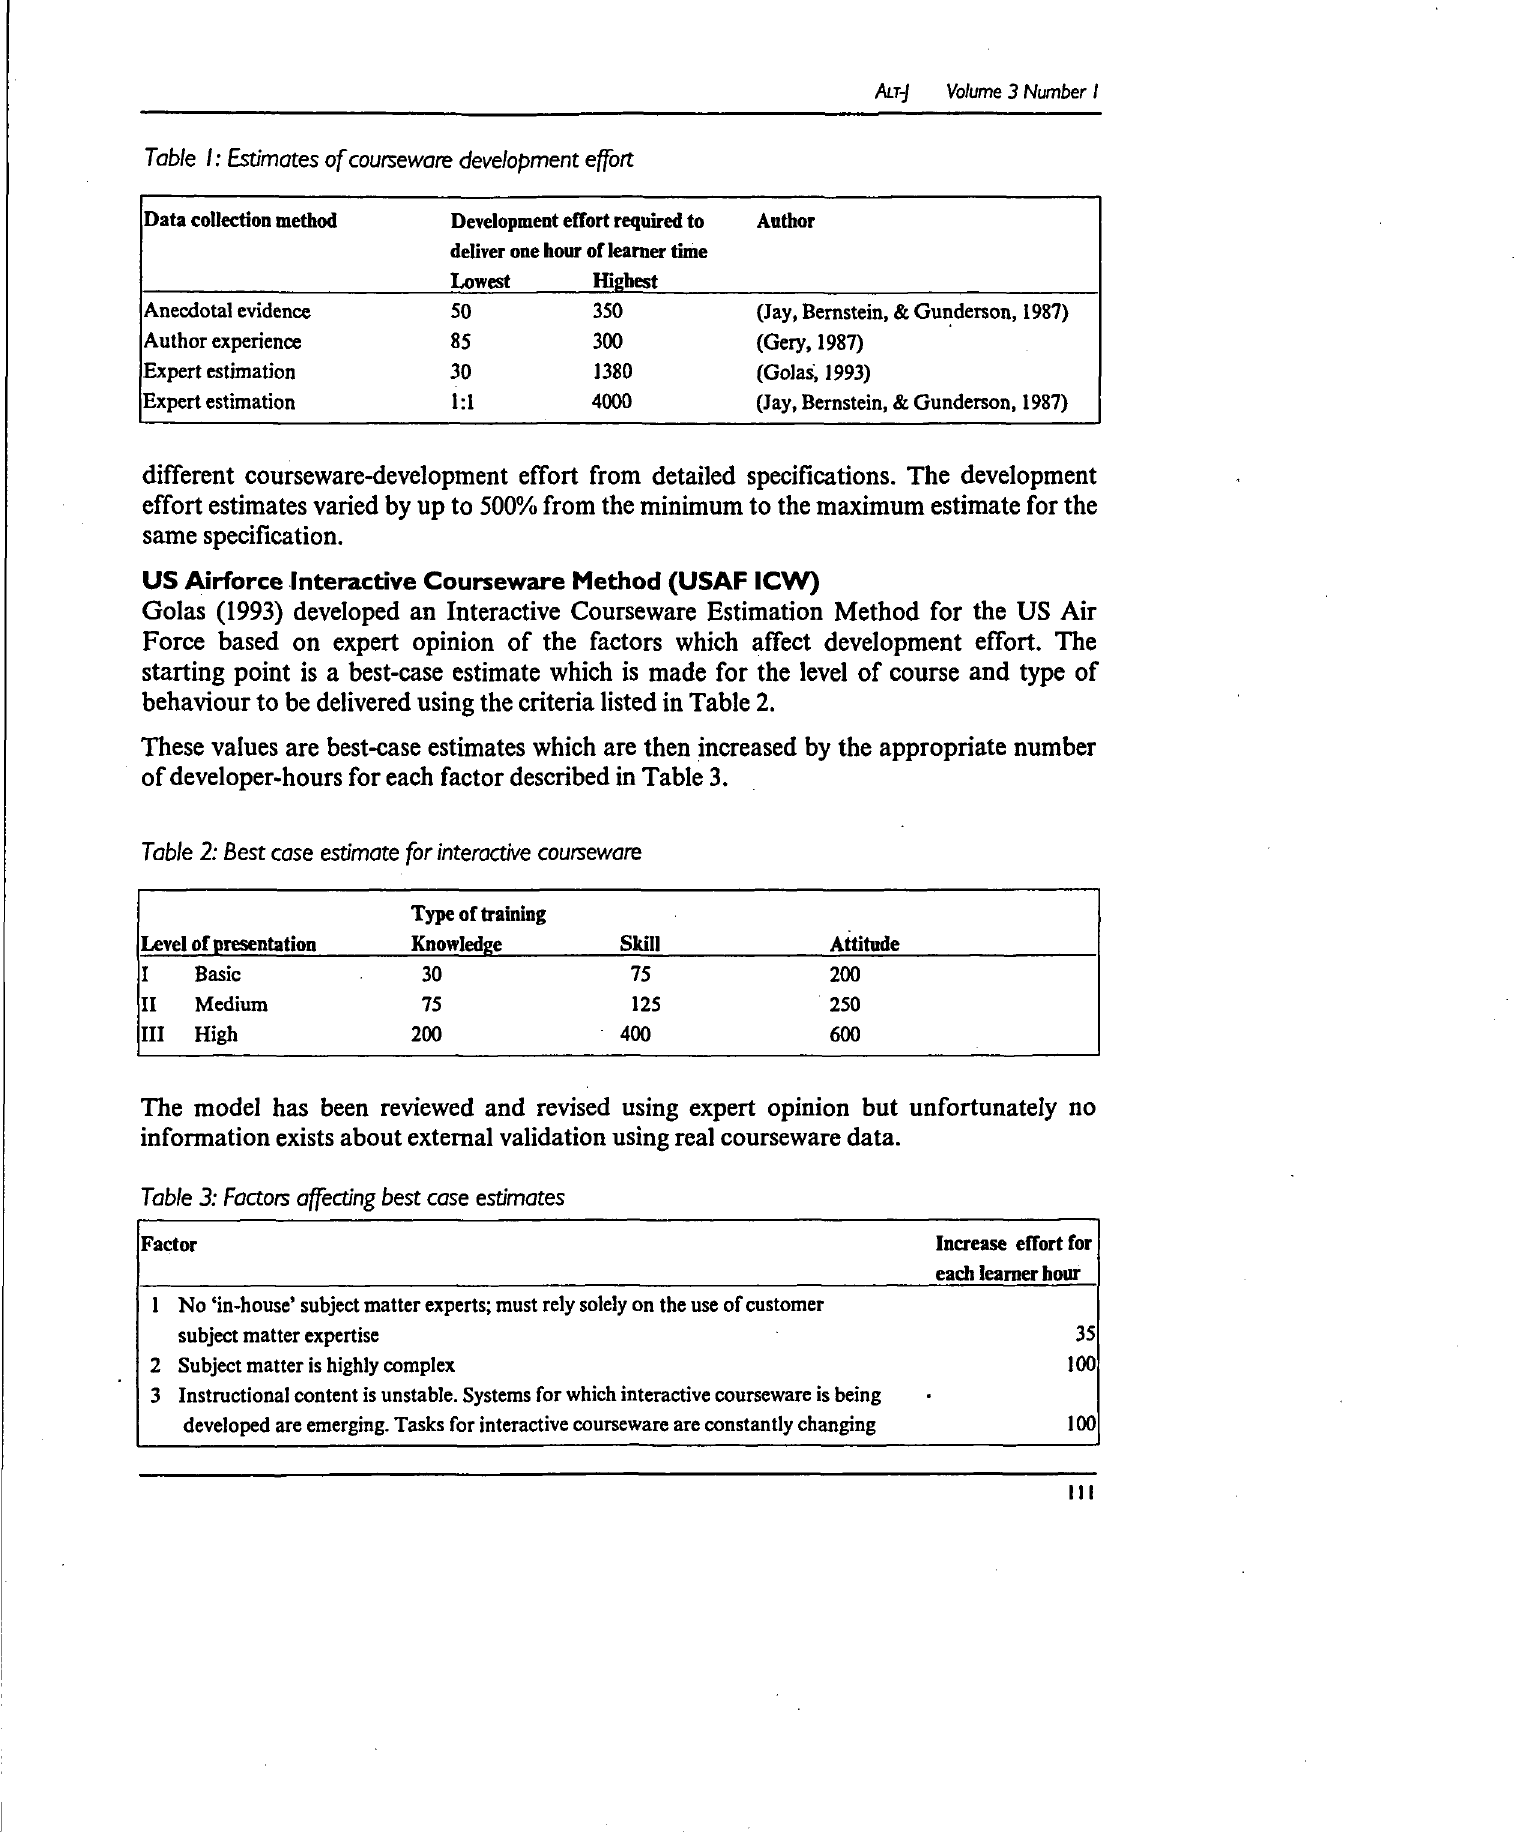
Table I: Estimates of courseware development effort